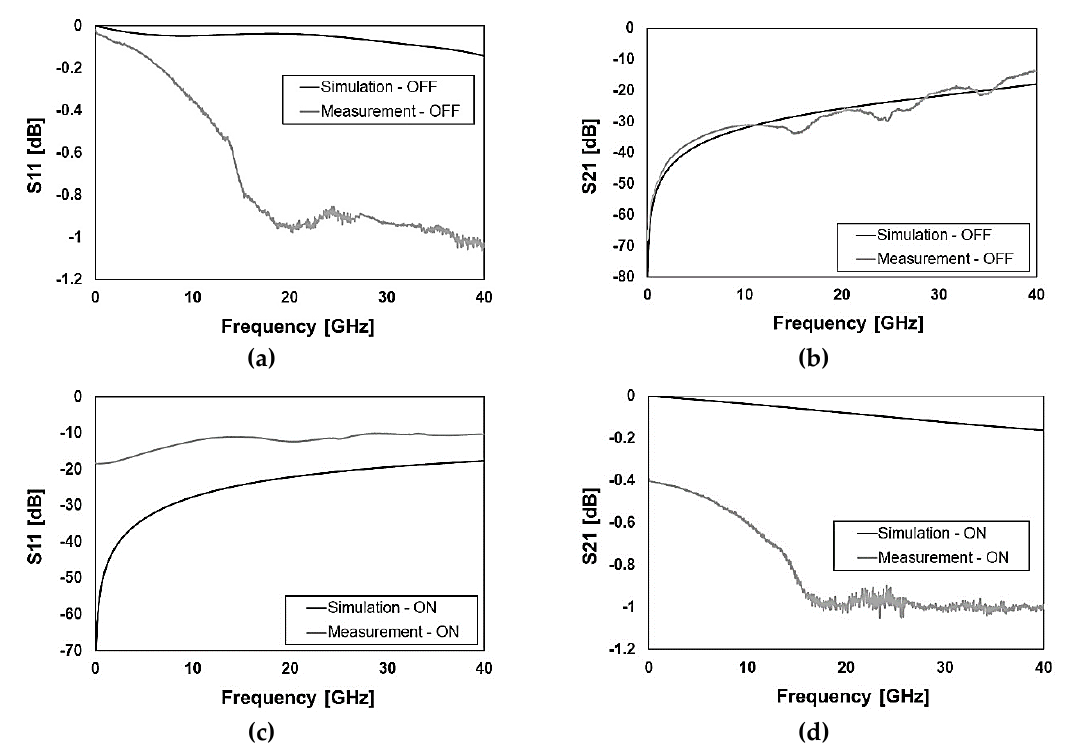
Figure 8. Measured versus simulated S-parameters characteristics of the longitudinal ohmic switch reported in Figures 2b and 3b with reference to ( a ) reflection (S11) in the OFF state; ( b ) isolation (S21) in the OFF state; ( c ) reflection (S11) in the ON state; ( d ) transmission (S21) in the ON state.